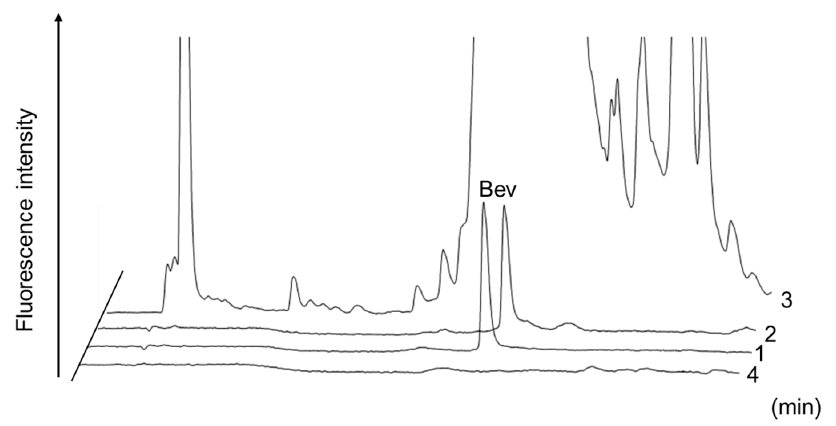
Figure 3. Chromatograms of the plasma samples spiked with 10 µ g/mL of bevacizumab. 1. With aptamer affinity purification; 2. with aptamer affinity purification affinity beads by used three times; 3. without aptamer affinity purification; 4. with aptamer affinity purification of drug-free plasma. Peak: Bev: bevacizumab.